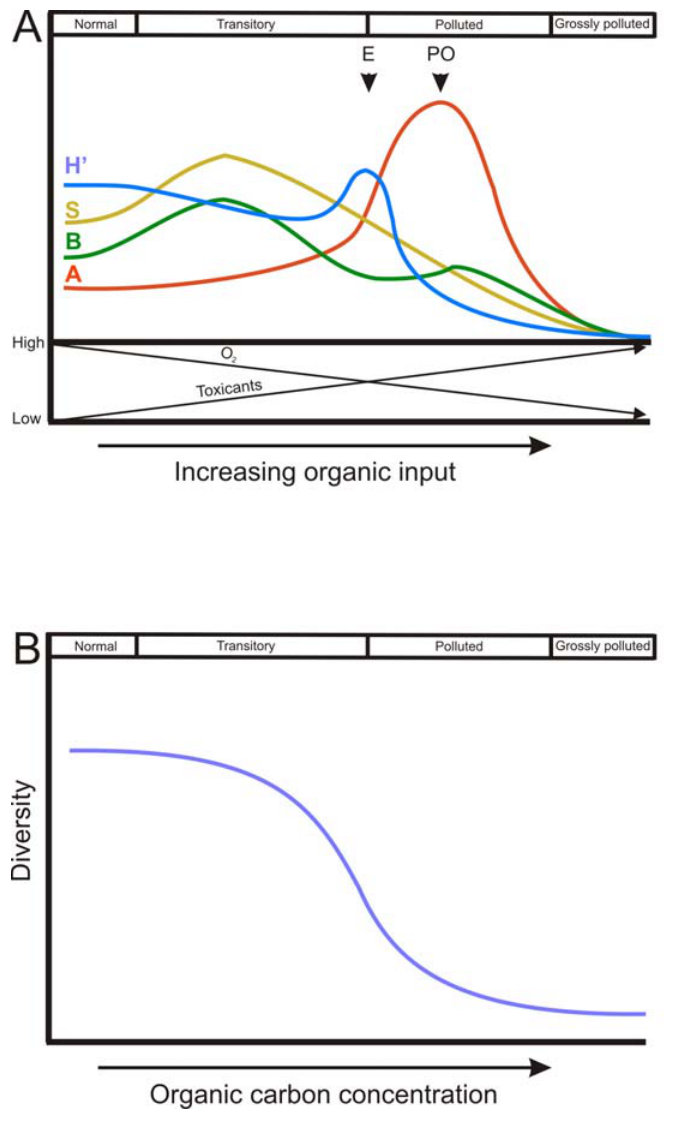
Figure 2. In both graphs, the upper boxes refer to the stages defined in the P-R model [44]. (A) Abundance (A), biomass (B), species richness (S) and Shannon-Wiener diversity ( H’ ) trends along an organic enrichment gradient according to the P-R model adapted from Pearson and Rosenberg [44] and Hyland et al . [46]. PO, peak of opportunists; E, ecotone point. At the bottom of the graph the two arrows show the tendency of oxygen and toxicant concentration in the sediment along an organic enrichment gradient. Toxicant refers to substances derived from the OM load which may cause pollution, such as: by-products , H S, and CH ), inorganic nutrients and derived from anaerobic metabolism (NH 3 2 4 pollutants. (B) General diversity (measured as H’ and Hurlbert’s diversity) trend observed along organic enrichment gradients from several areas in the world